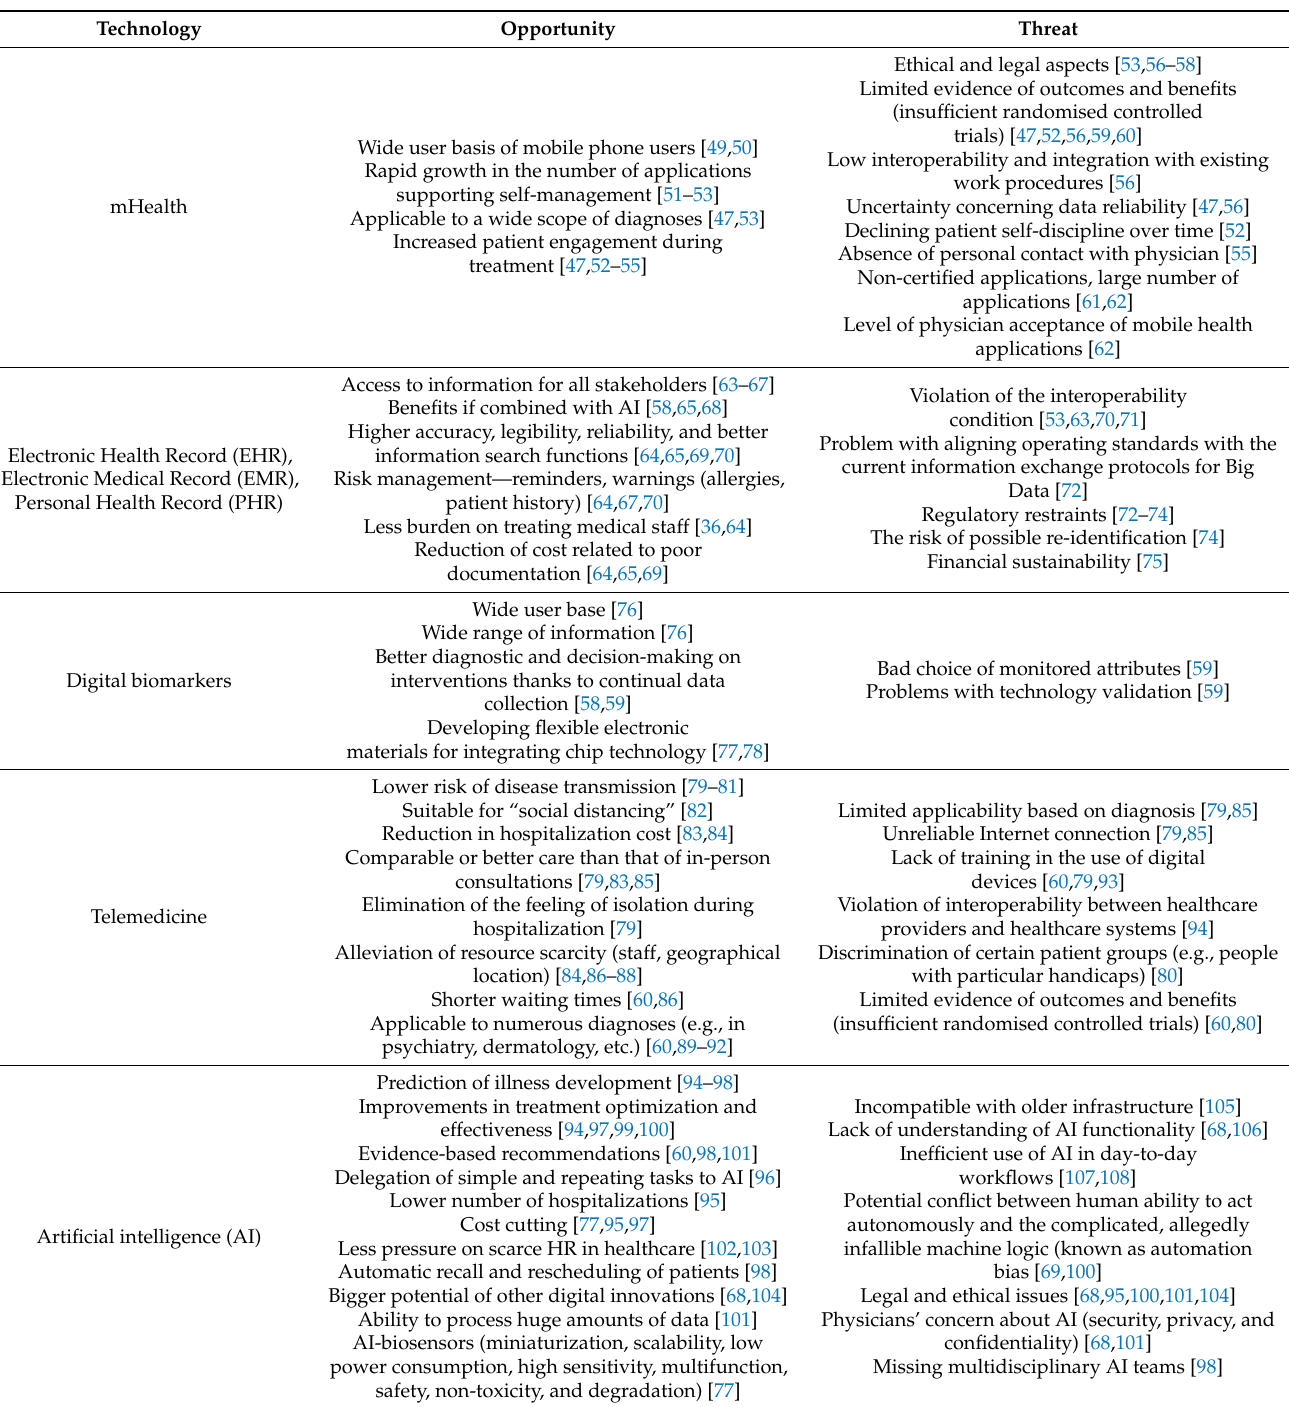
Table 8. Opportunities and threats for digital